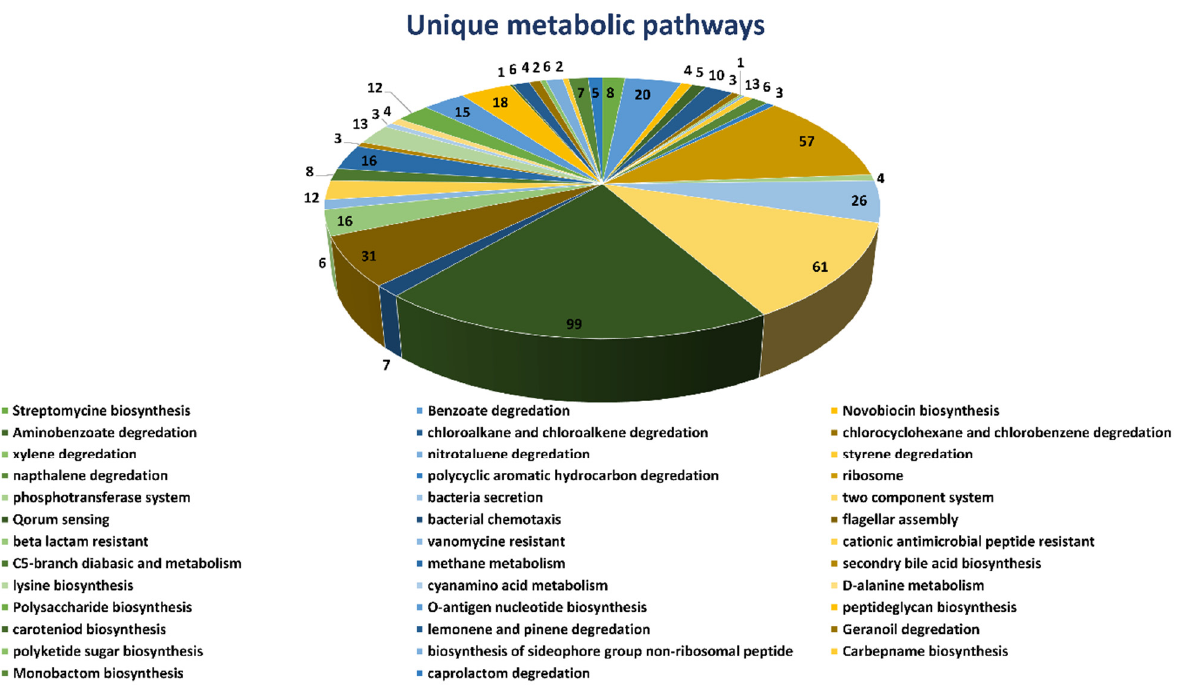
Figure 1. Unique metabolic pathways. Schematic representation of unique metabolic pathways found in Brucella suis along with the number of proteins identified in it.